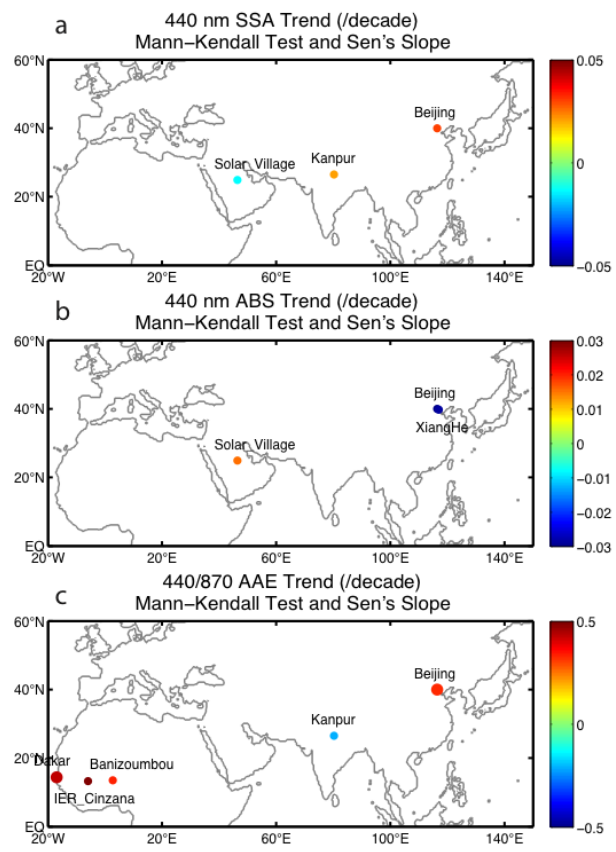
Figure 8. Trends for the SSA (a) , ABS (b) and AAE (c) parameters at the seven stations with sufficient level 2.0 inversion data. Only trends above 90% significance level are